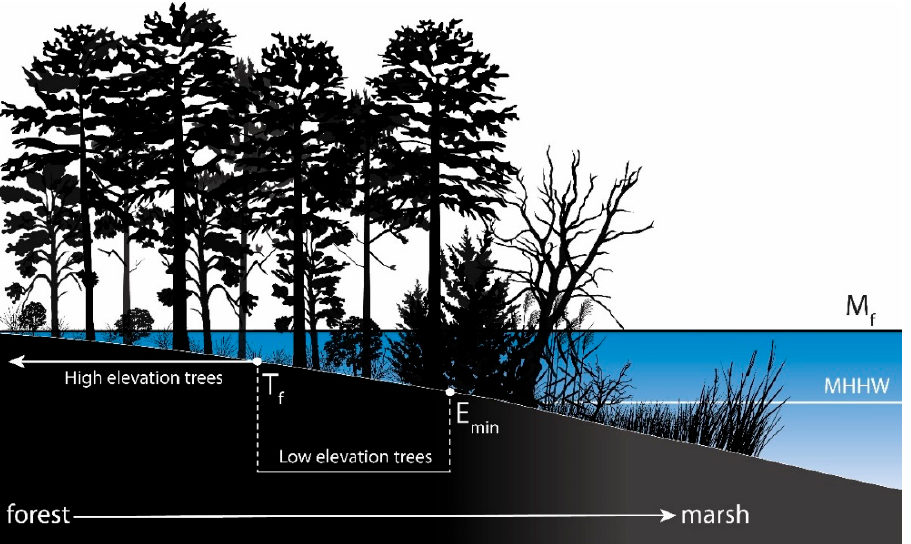
Figure 2. Diagram of elevation gradient from marsh to forest, where high and low elevation trees were sampled above mean higher high water (MHHW). High and low elevation trees were separate by a flood level threshold (T f ), which is a function of site-specific metrics such as the maximum recorded flood elevation (M f ) and the lowest sampled tree elevation (E min ).